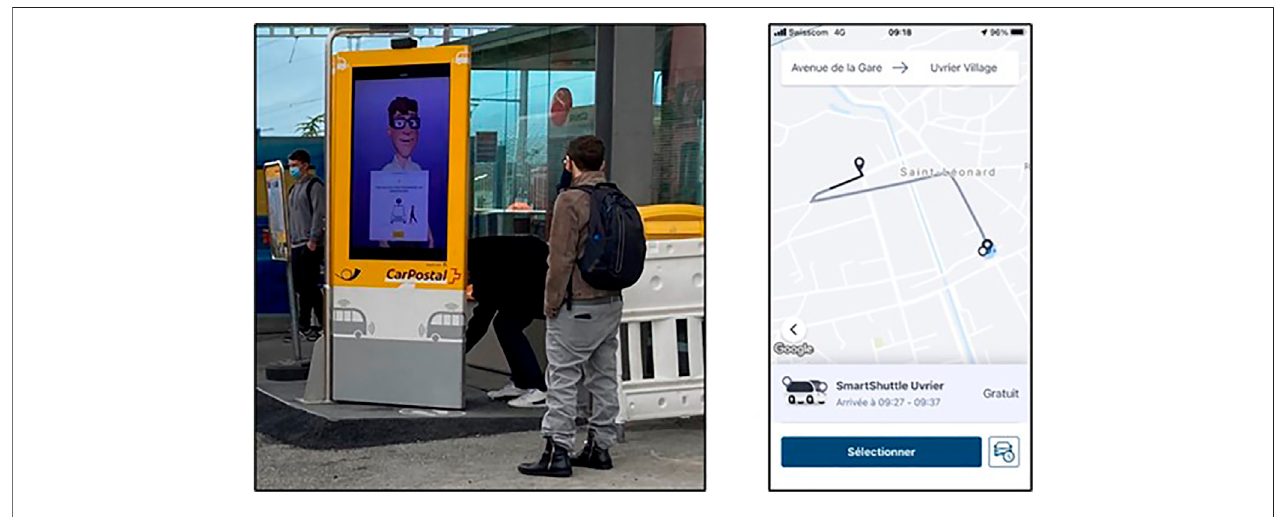
FIGURE 2 | Avatar screen and smartphone application to book an AV.